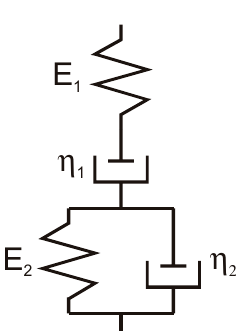
Figure 1. Burgers rheological model. E 1 : immediate elastic modulus in the Burgers model (Pa); E 2 : delayed elastic modulus in the Burgers model (Pa); η 1 : viscosity coefficient in the Burgers model (Pa·s), η 2 : viscosity coefficient of elastic delay in the Burgers model (Pa·s).